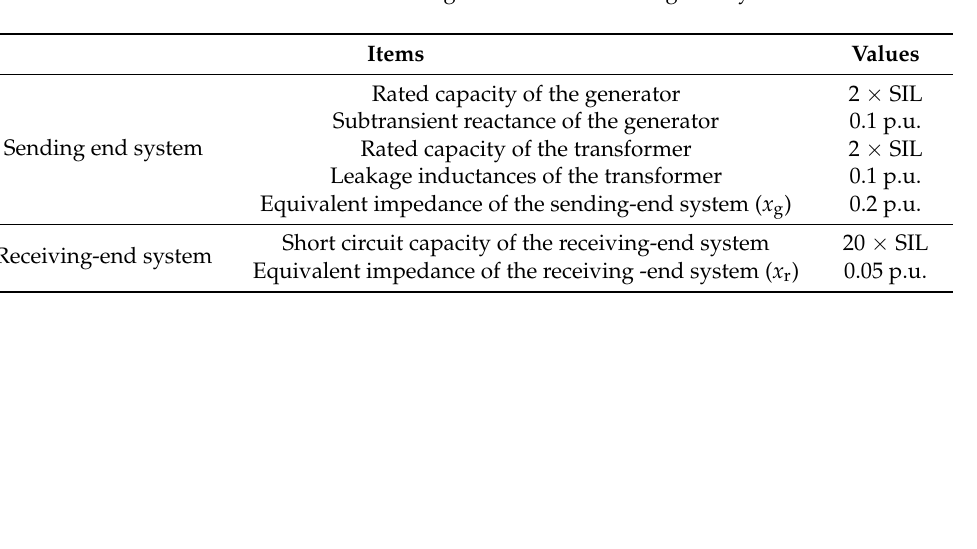
Table 2. Parameters of the sending-end and the receiving-end